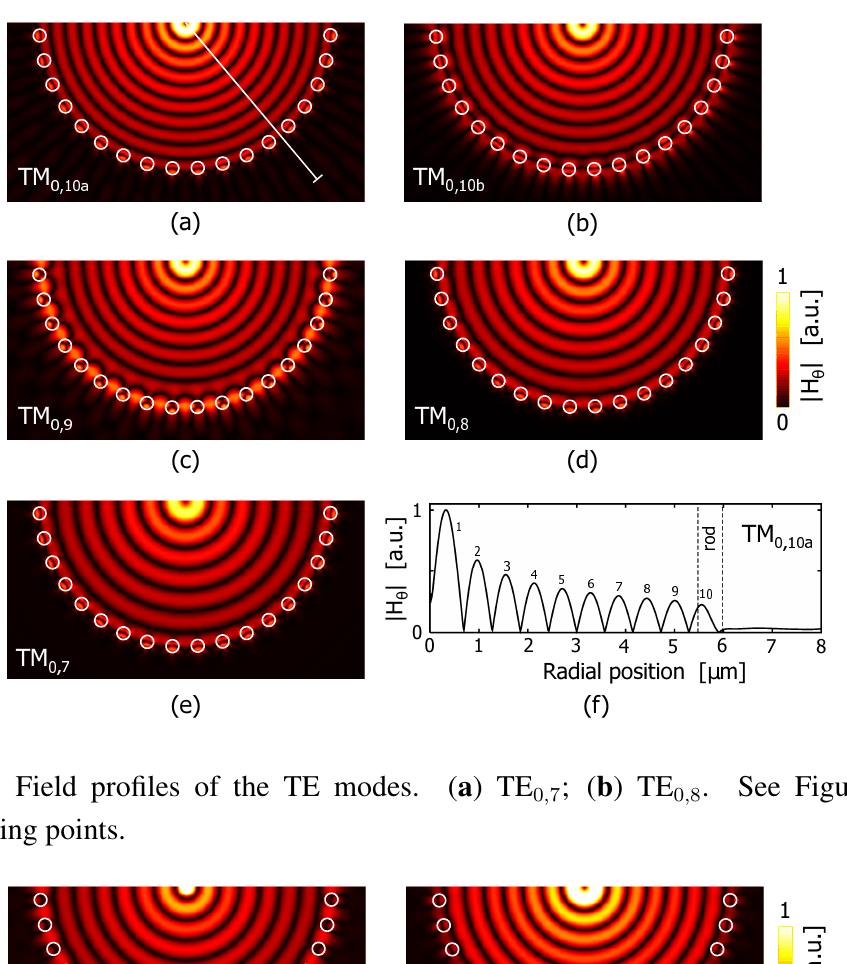
; ( b ) TE . See Figure 2b for 0 ; 7 0 ; 8